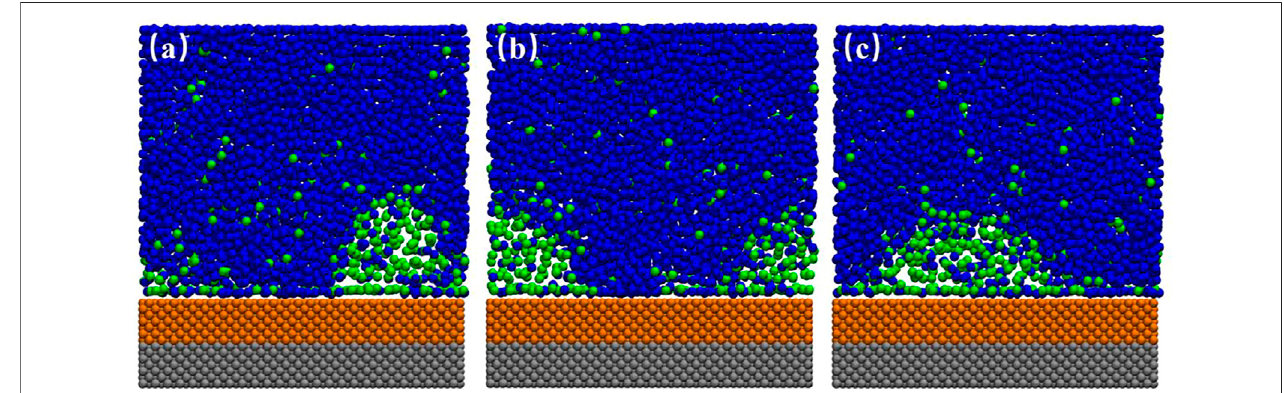
FIGURE 2 | Snapshots of simulation for S M surface. (A) 20.1 ns, (B) 21.0 ns, (C) 24.5 ns. In this case, 300 gas particles and 4,000 liquid particles were randomly fi lled into the simulation box with a typical size of 10.20 × 2.75 × 11.00 nm 3 in x-, y-, and z-direction. The blue and green beads represent the liquid and gas particles, respectively, and the silver and orange beads represent the fi xed solid particles of S L and S M . A movie for the process is available as Supplementary Video S1 .